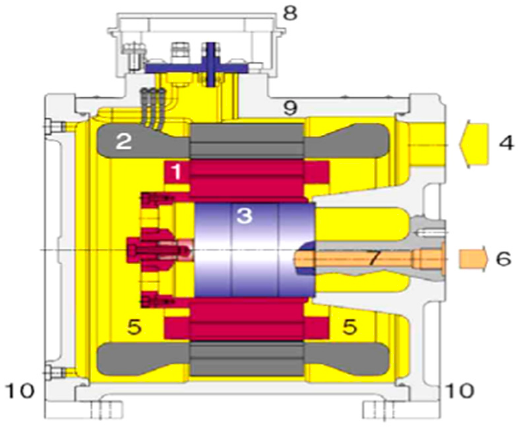
Figure 1. EPAI of VOITH.